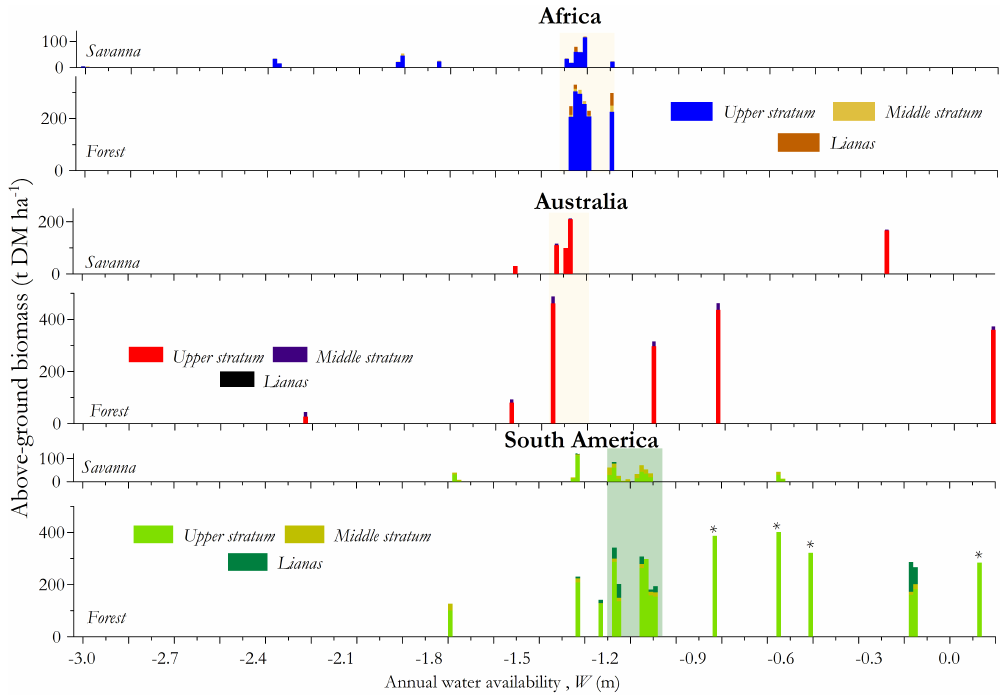
Figure 9. Variations in estimates of biomass of forest and savanna across the three continents; studies divided into the upper-canopy stratum (diameter at breast height, D > 0 . 1m), middle canopy stratum (0.1m < D < 25mm) and lianas plotted as a function of mean annual water availability, W (Eq. 3). For each continent, the approximate location of the main studied forest–savanna transition zone(s) are indicated by grey shading. For South America, extra sites at low W (upper stratum only) have also been included and these are indicated by an